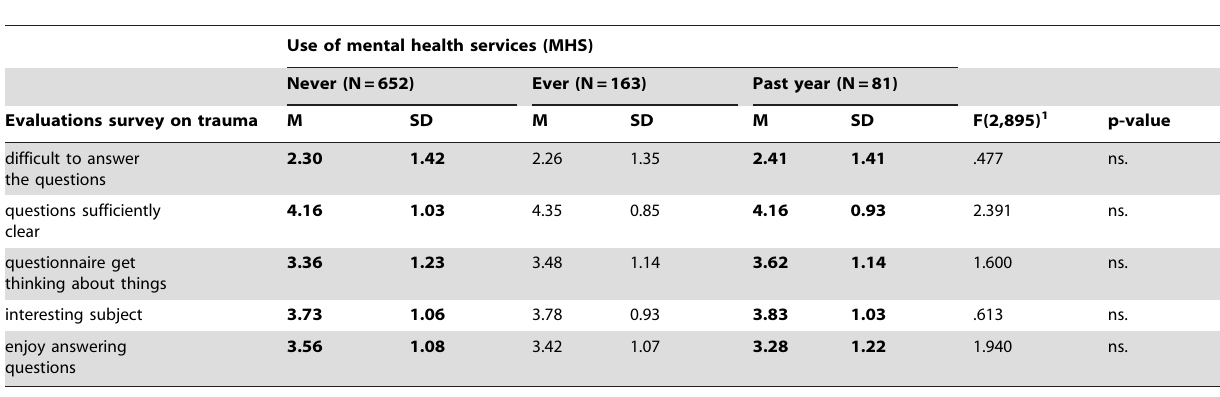
Table 5. Differences in burden of research on trauma between non-MHS users, ever MHS users and MHS users in the past year.